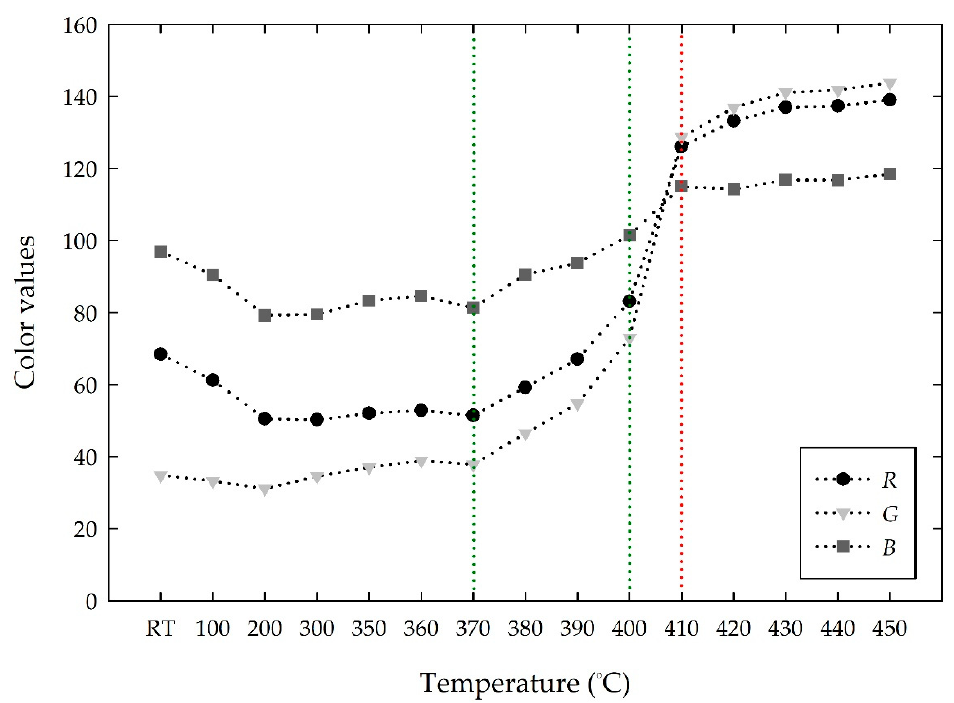
Figure 2. Changes in the RGB values of the MV pigment with increasing temperature.